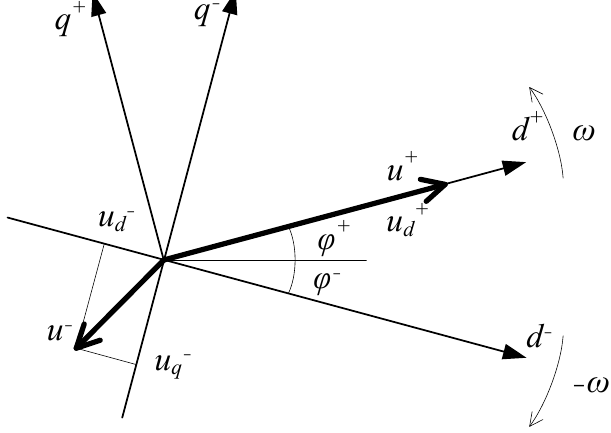
Figure 3. Block scheme of the proposed shunt-conditioner control system (* denotes reference val- ues). Figure 4. Figure 4. Phasor representation of voltages in DSRF.